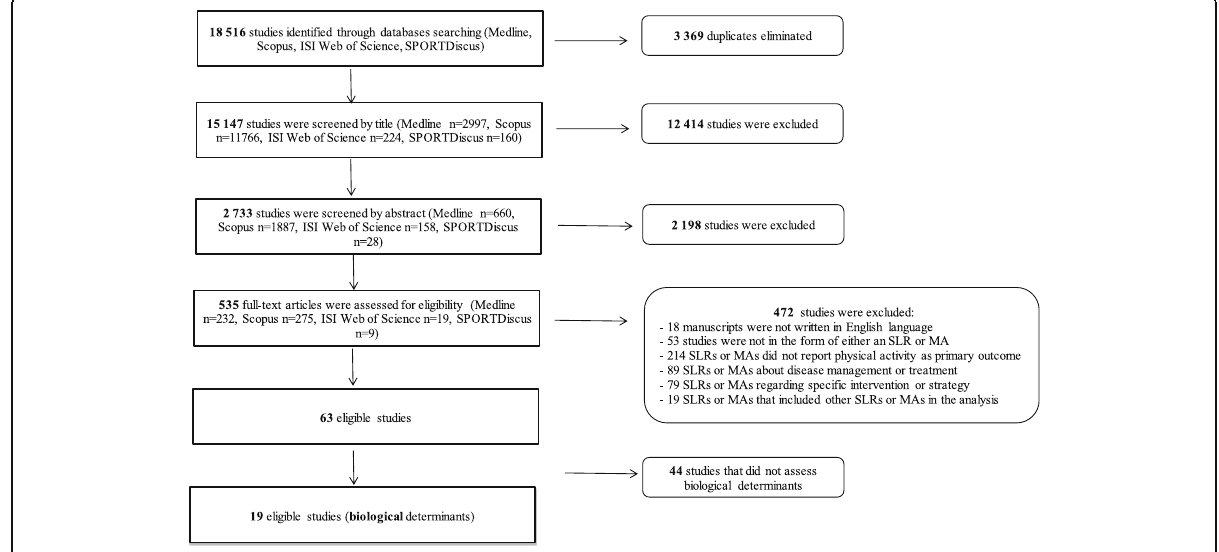
Fig. 1 Flowchart of the literature research by database. MA meta-analysis, SLR systematic literature